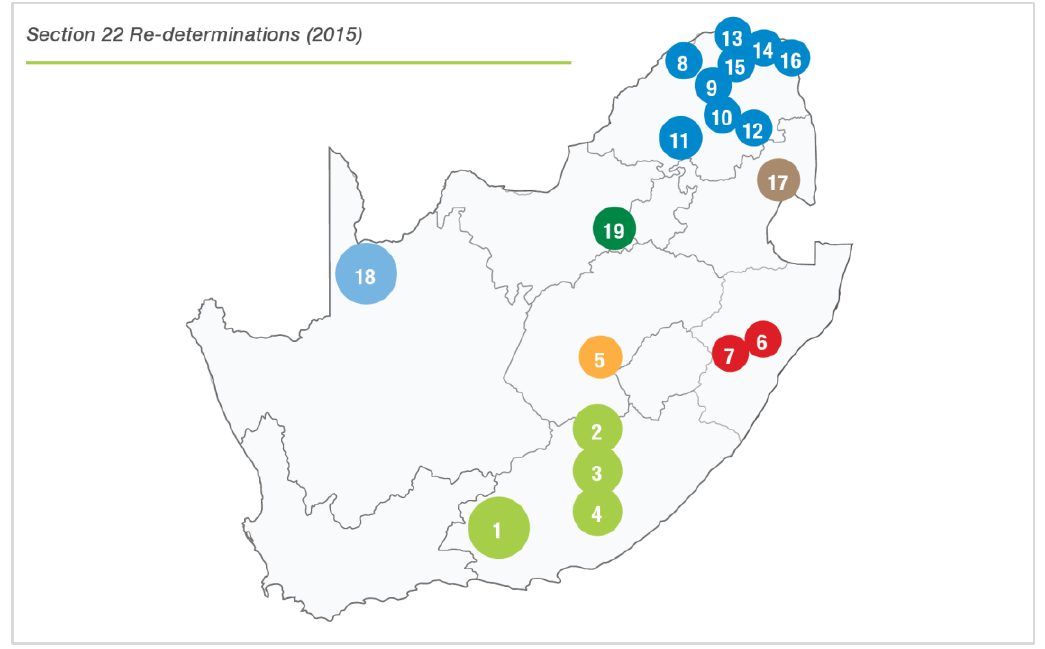
Source: Municipal Demarcation Board (2016, p.